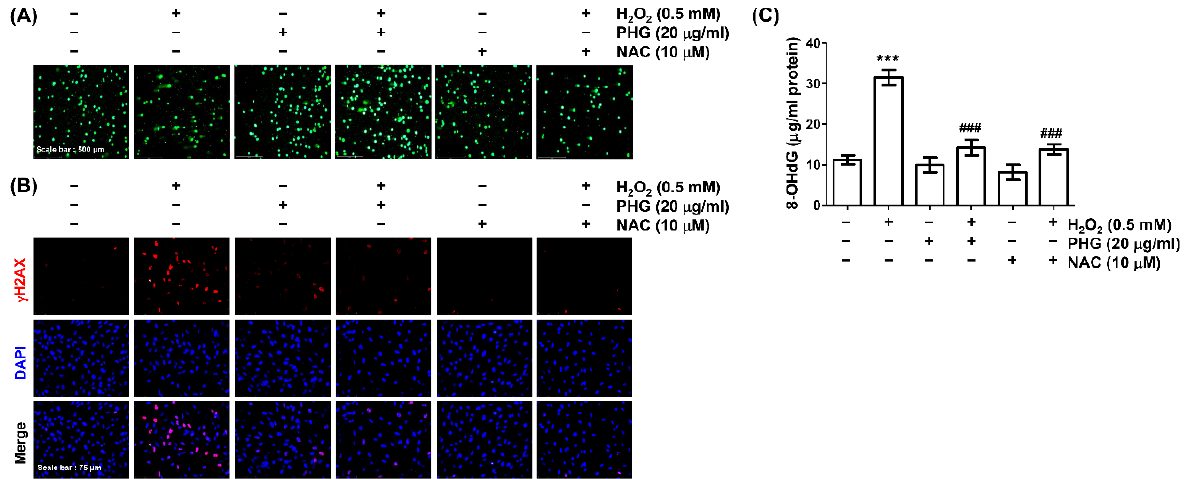
Figure 4. Phloroglucinol alleviates H 2 O 2 -induced DNA damage in ARPE-19 cells. Cells were treated with or without phloroglucinol or NAC for 1 h prior to treatment with H 2 O 2 for 24 h. ( A ) Representative immunofluorescence images of comet assay are indicated. ( B ) Representative images of γ H2AX immunofluorescence (red) observed with a fluorescence microscope are shown. The location of the nucleus was indicated by counterstaining with DAPI (blue). ( C ) After treatment, contents of 8-hydroxy-2 (cid:48) -deoxyguanosine (8-OHdG) were measured using an ELISA kit. *** p < 0.001 vs. unstimulated control; ### p < 0.001 vs. H 2 O 2 alone